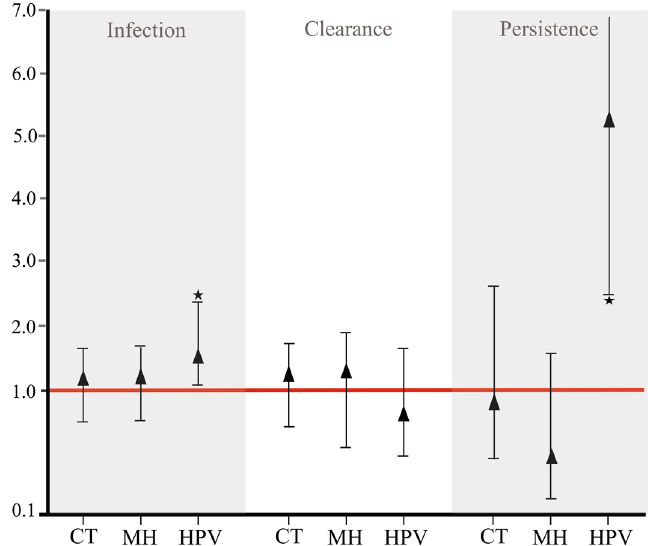
Figure 1. Adjusted hazard ratio for modelling the relationship between CT, MH and HPV and TV-outcome (infection, clearance and persistence). The reference group consisted of those women who were CT-, MH- or HPV-free.